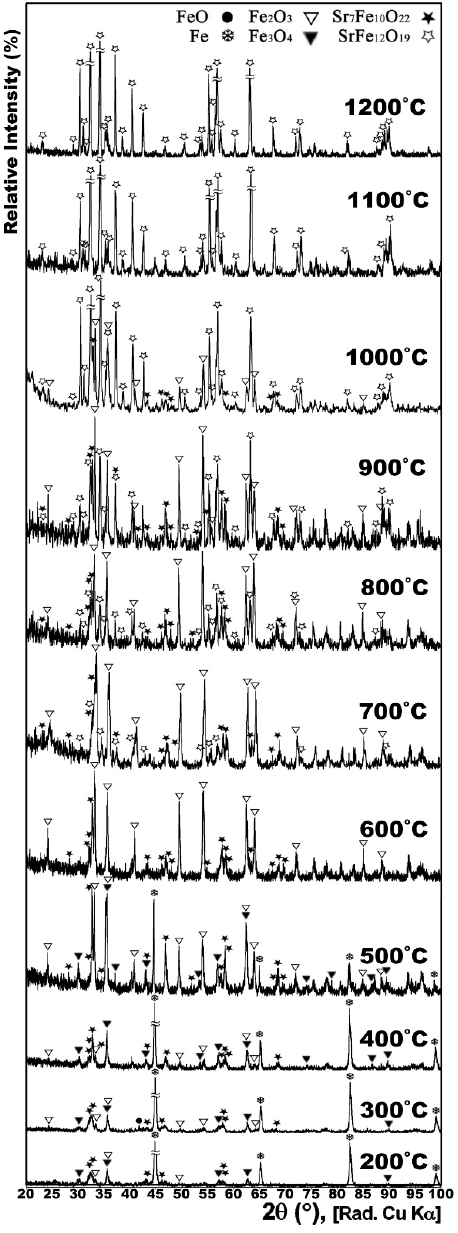
Figure 8. XRD patterns of the CH 4 heat treated powder, calcined at 200, 300, 400, 500, 600, 700, 800, 900, 1000, 1100 and 1200 °C for 1 h.